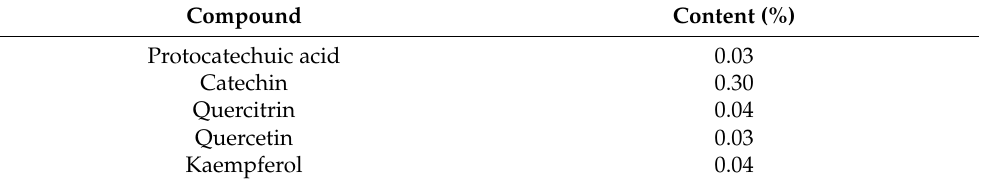
Table 5. The amount of constituents in